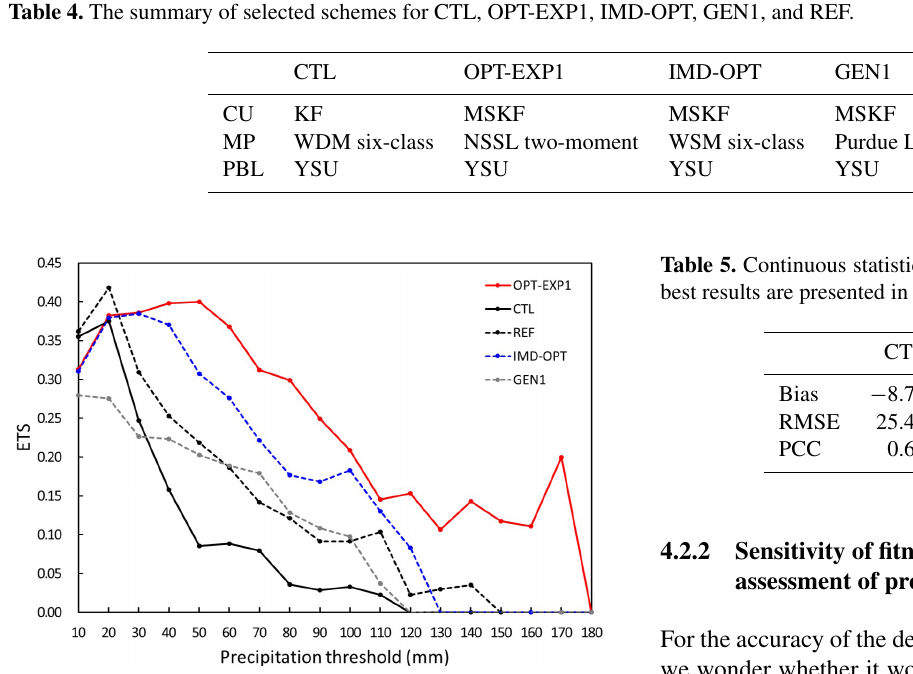
Figure 4. ETS for 12h accumulated precipitation with each precip- itation threshold for CTL (black line), OPT-EXP1 (red line), IMD- OPT (dashed blue line), GEN1 (dashed gray line), and REF (dashed black line).